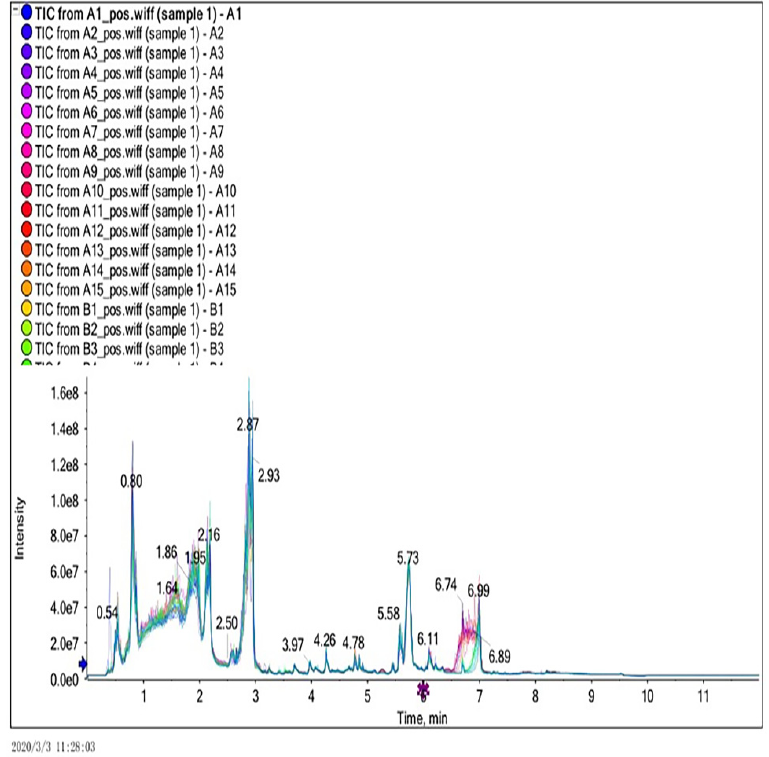
Metabolites 2022 , 12 , x FOR PEER REVIEW 1 Figure 1. Total ion current diagram in positive ion mode.